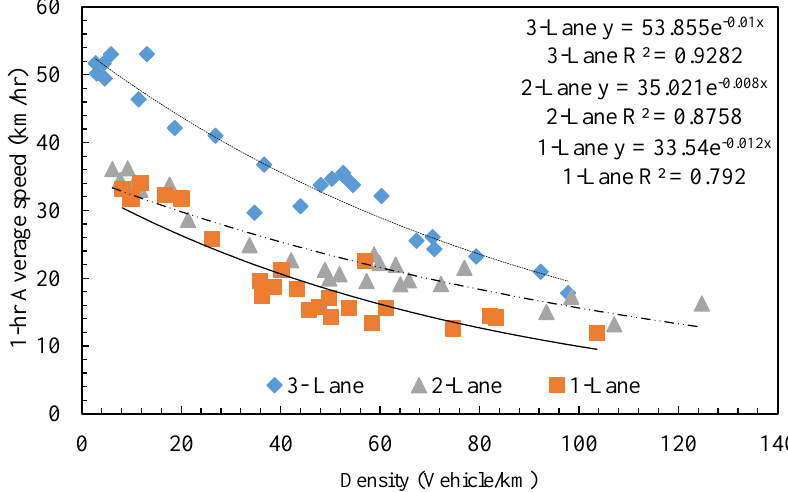
Figure 5. Traffic models of roads with different number of lanes in Bangkok .